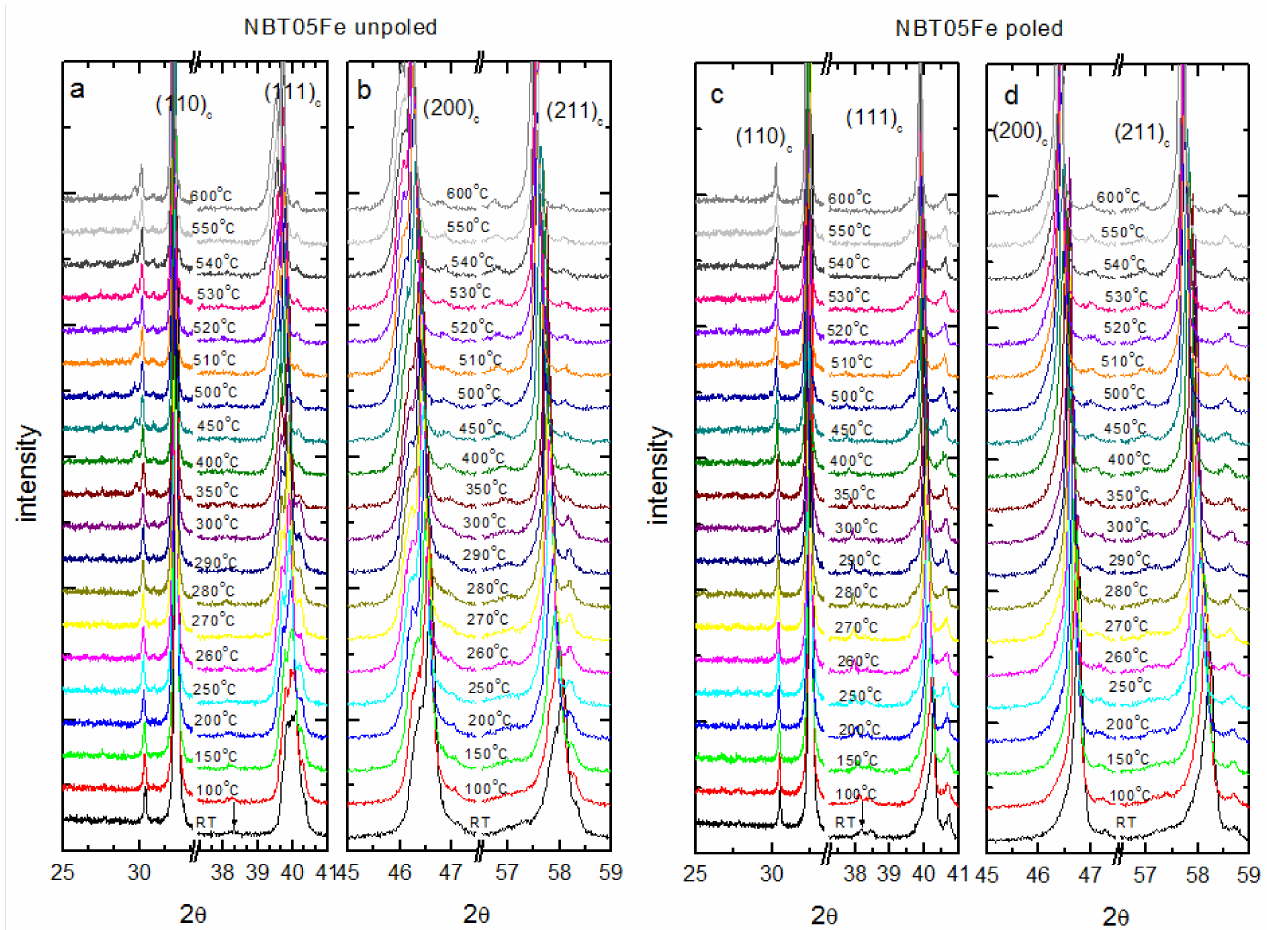
Figure 3. Temperature variation in the (110) c , (111) c and (200) c Bragg peaks of the NBT05Fe in ( a , b ) unpoled and ( c , d ) poled state. The “c” subscript corresponds to the cubic phase. The arrows show the superlattice reflection of the rhombohedral R3c